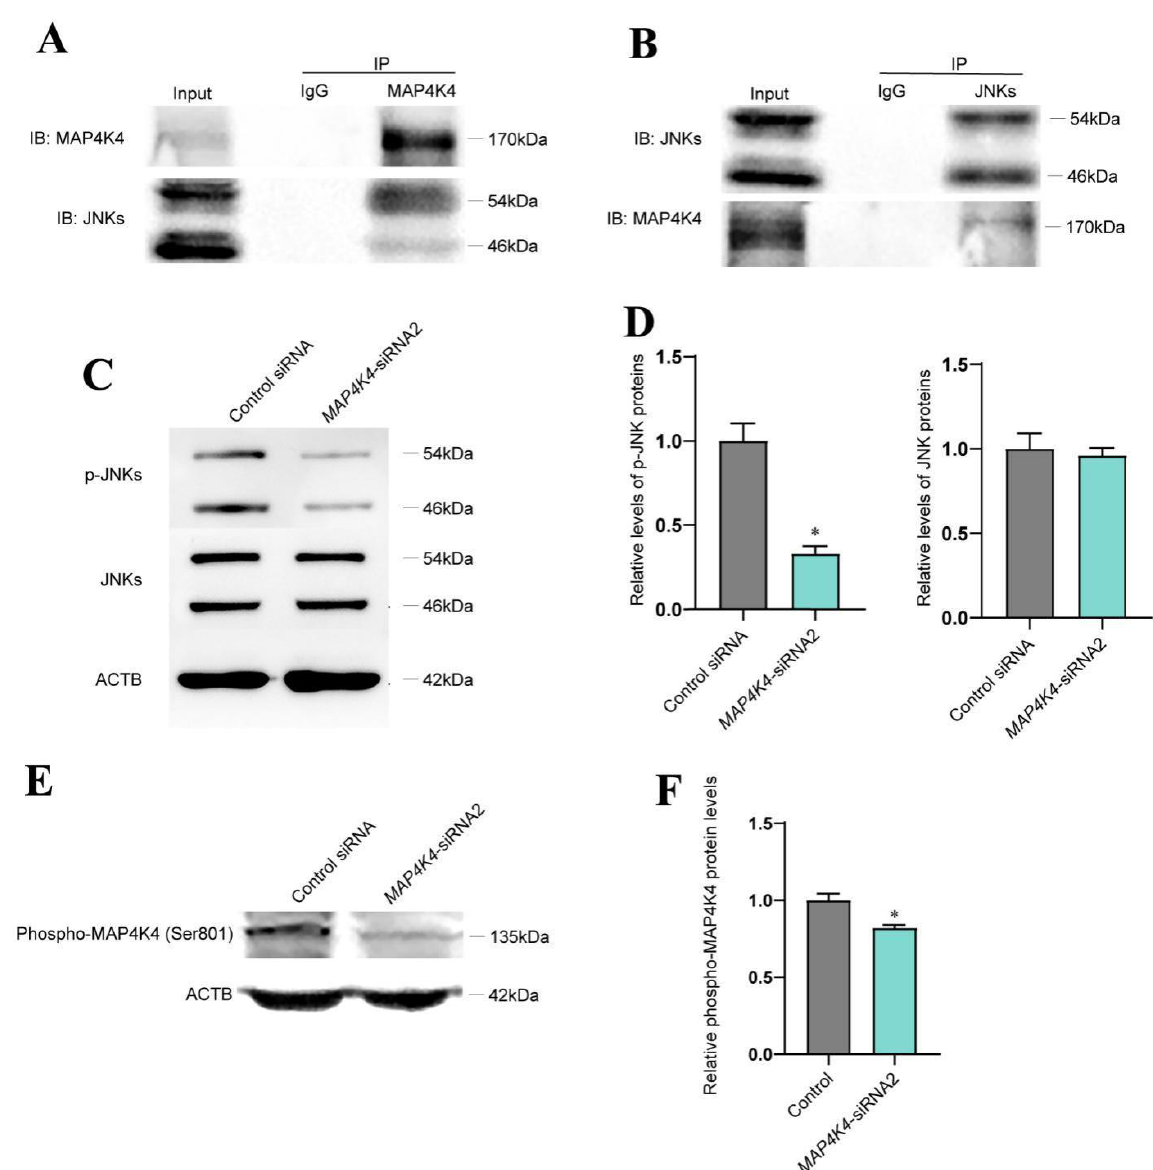
Figure 4. MAP4K4 silencing reduced the phosphorylation of JNK in human SSC line. ( A , B ) The Co-IP assay indicated an interaction between MAP4K4 and JNK. ( C , D ) Western blotting showed the level changes of p-JNK protein in human SSC line after MAP4K4 knockdown. ( E , F ) Western blotting showed that at 72 h after transfection with MAP4K4-siRNA2, the ratio of p-MAP4K4 at Ser801 to total MAP4K4 in human SSC line was decreased. * represents p < 0.05.